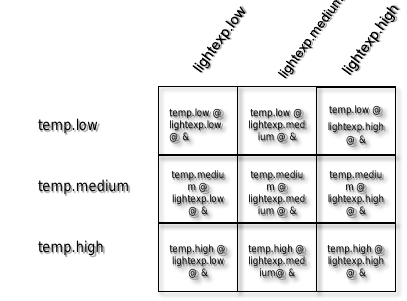
Figure 7. The rule generation involves the evaluation of all the possible combinations of the truth values of each membership function. Finally, the rule aggregation process consists in scanning the table to return the cell index storing the rule with the maximum strength. This index represents the class the node belongs to.